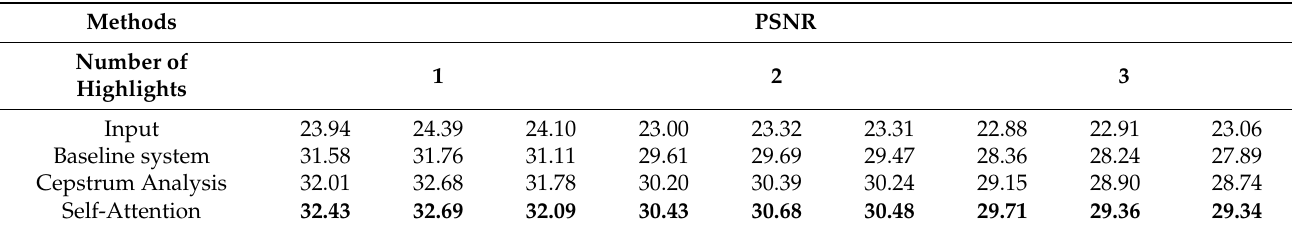
Table 3. Ablation study for the